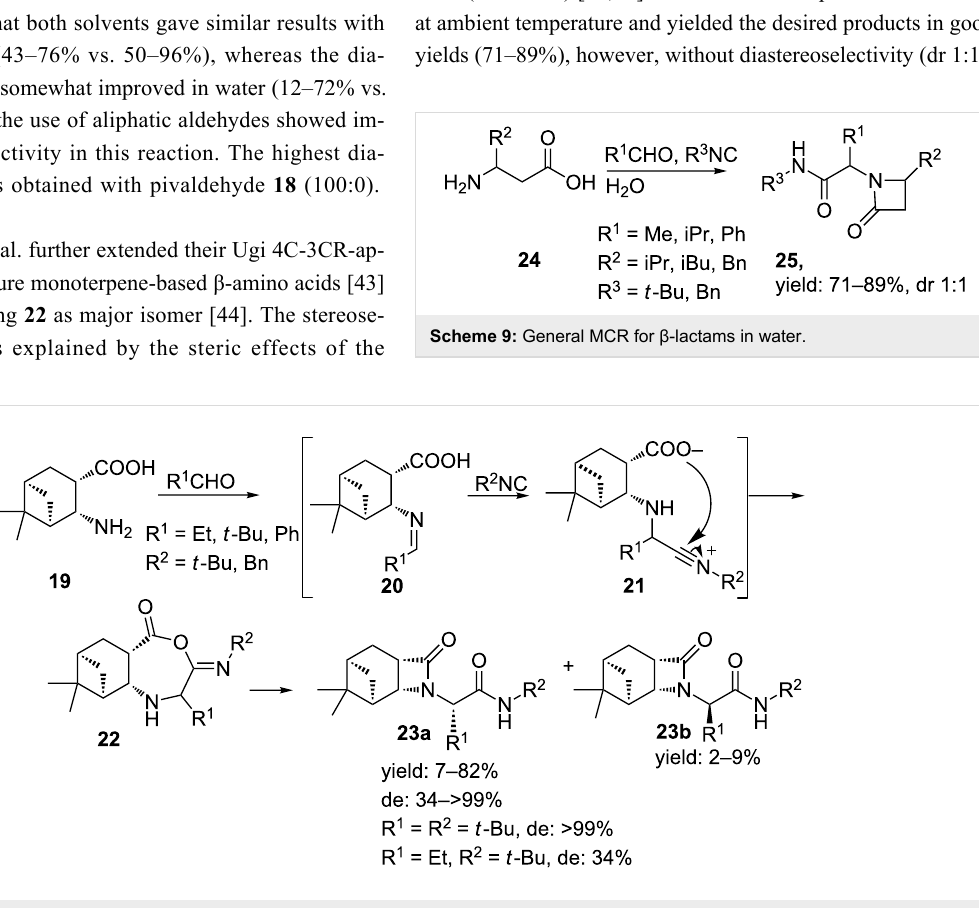
Scheme 8: Ugi MCR between an enantiopure monoterpene based β -amino acid, aldehyde and isocyanide resulting in bicyclic β -lactams.